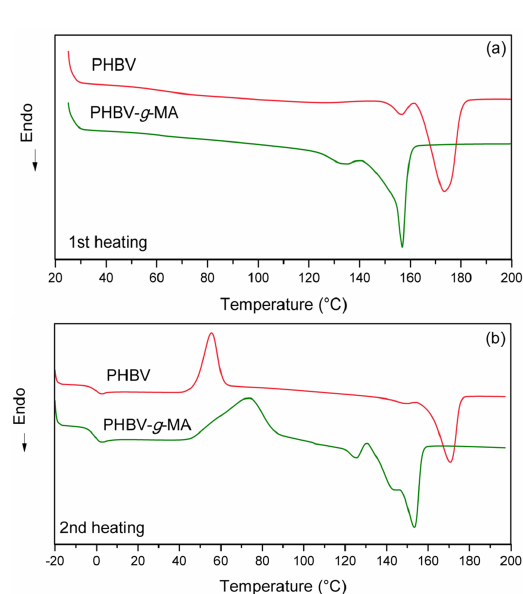
Figure 6. DSC curves for neat PHBV and PHBV- g -MA: (a) first heating and (b) second heating